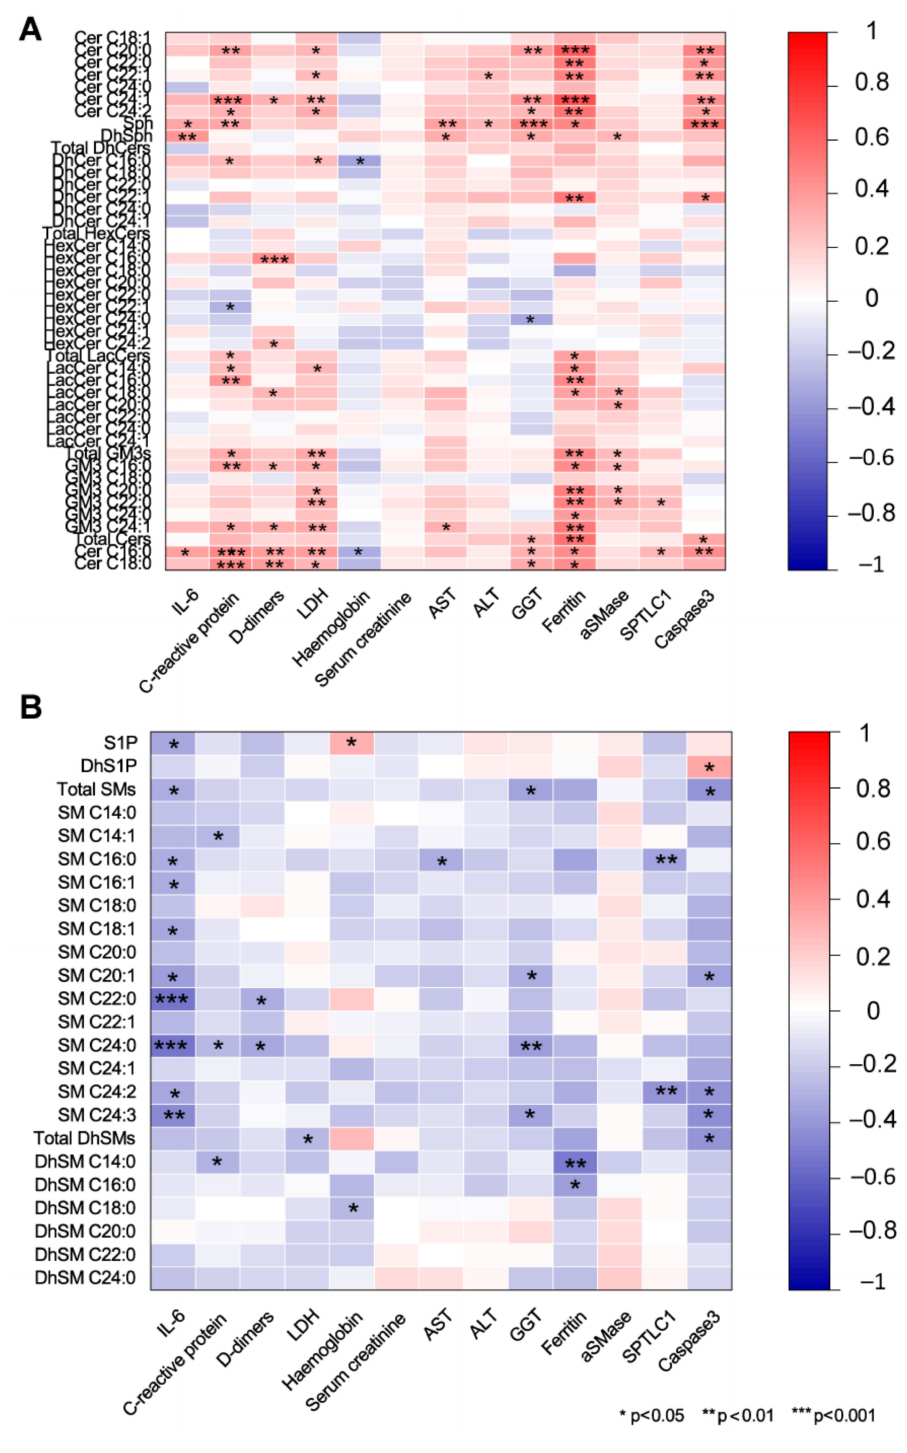
Figure 8. Spearman correlations between sphingolipid serum levels and circulating markers (IL-6, C-reactive protein, D-dimer, lactate dehydrogenase, hemoglobin, serum creatinine, aspartate aminotransferase, alanine aminotransferase, gamma-glutamyl transpeptidase, ferritin, and acid sphingomyelinase). ( A ) Ceramides, sphingosine, dihydrosphingosine, dihydroceramides, hexosylceramides, lactosylceramides, GM3s showed positive associations with all circulating mark- ers except for hemoglobin, whereas ( B ) S1P, sphingomyelins, and dihydrosphingomyelins were negatively correlated. * p -value < 0.05, ** p -value < 0.01, *** p -value <